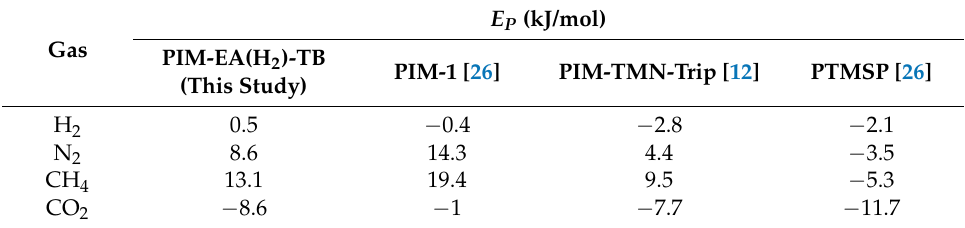
Table 5. Activation energy of gas permeation for PIM-EA(H 2 )-TB, PIM-1, PIM-TMN-Trip and PTMSP.